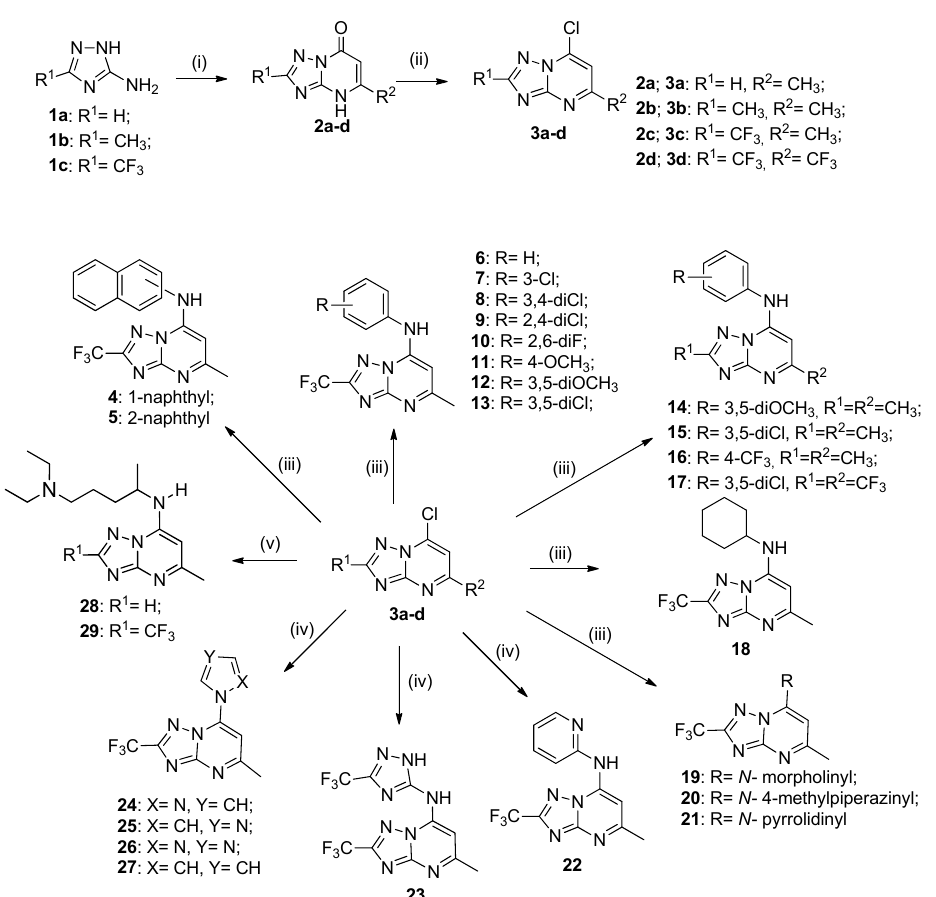
Figure 3. Synthesis of [1,2,4]triazolo[1,5- a ]pyrimidines 4 – 29